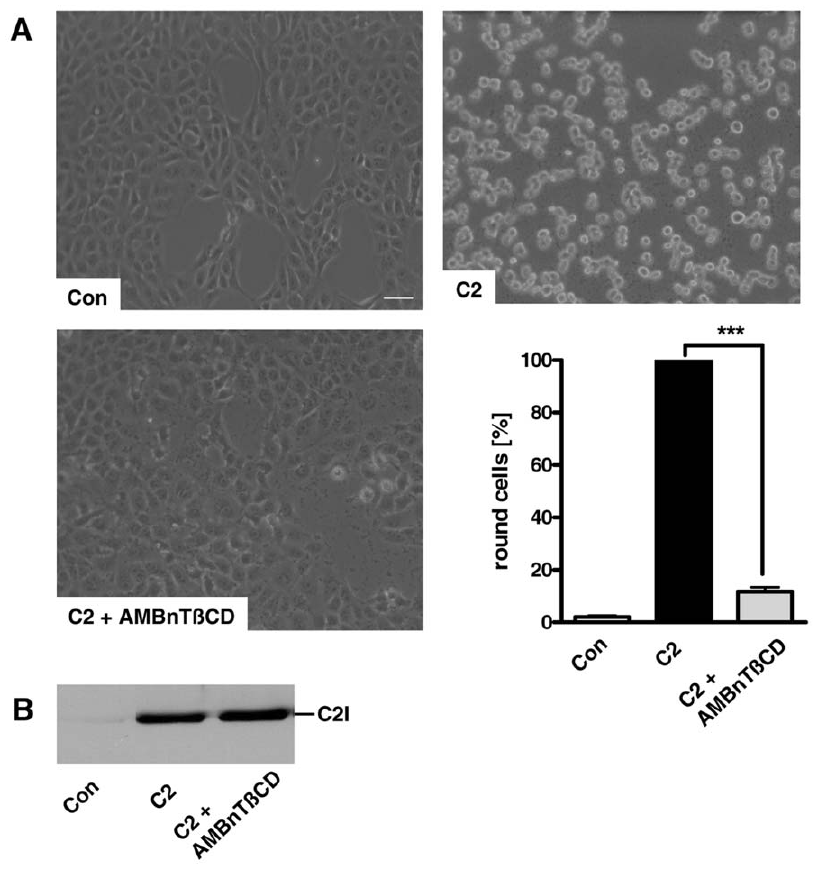
Figure 5. Effect of AMBnTßCD on receptor binding of C2 toxin. Vero cells were incubated for 30 min at 4 u C with C2 toxin (200 ng/ml C2IIa + 100 ng/ml C2I) to enable toxin binding to the receptor on the cell surface. Then, the medium was removed and cells were washed to remove any unbound toxin. Fresh medium containing 10 m M of AMBnTßCD was added and cells were further incubated at 37 u C to trigger internalization of the cell-bound C2 toxin. As a control, cells were incubated with fresh medium without AMBnTßCD or left untreated. After 3 h, pictures were taken to determine the percentages of round cells (scale bar=100 m m) ( A ). Values are given as mean 6 S.D. (n=3) and significance was tested between toxin- treated samples with or without AMBnTßCD by using the student’s t-test (***p , 0.0005). B . Western blot detection of cell-associated C2I protein. Equal amounts of cell lysate proteins were subjected to SDS-PAGE, blotted and C2I was visualized in a Western blot with a specific antibody against the N-terminal domain of C2I. Purified C2I protein was run as a control in the same gel (not